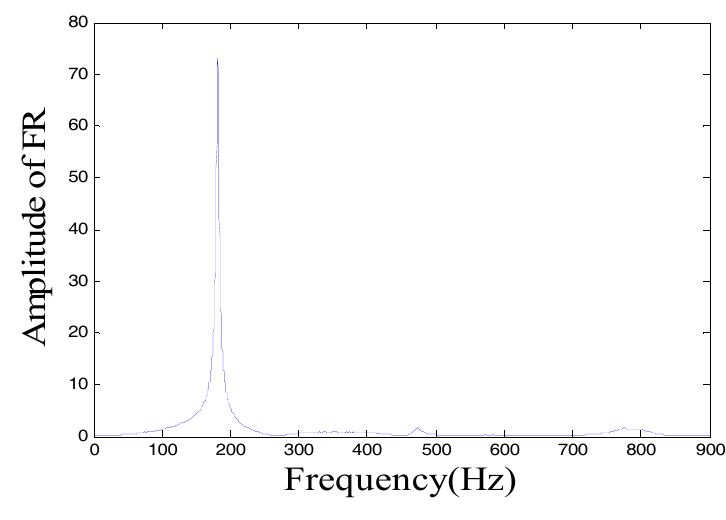
Figure 6. Frequency response.